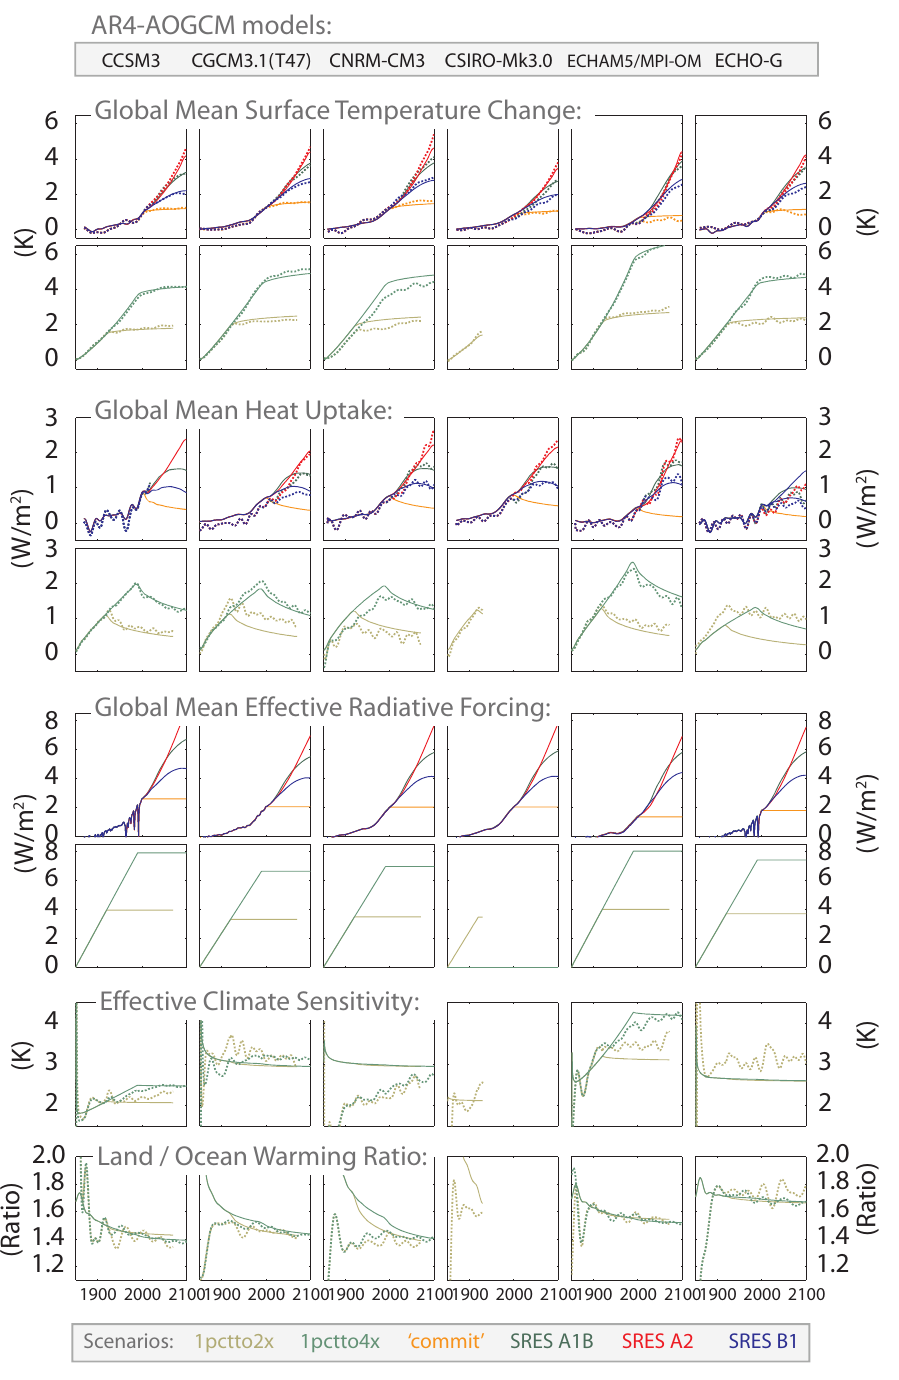
Fig. B1. Comparison of global-mean surface temperature (rows 1 and 2), heat uptake (rows 3, 4), effective radiative forcing (rows 5, 6), the effective climate sensitivity (row 7) and the land-ocean warming ratio (8), between CMIP3 AOGCM models (dotted) and the calibrated MAGICC6 (solid) model (calibration III with “like-with-like” AOGCM specific forcing) from 1850 to 2100. Shown are the comparisons for the idealized CO 2 -only scenarios (1pctto2 × and 1pctto4 × ) set to start in 1850 and the multi-forcing runs for the 20th century (20c3m), three SRES scenarios, and the commitment run. For the multi-gas scenarios, MAGICC is driven here by the AOGCM-specific subsets of forcing agents (see Table 2). AOGCM drift was removed by substracting the respective lowpass-filtered control run segments. Both the AOGCM and the MAGICC temperature outputs were lowpass-filtered using a low pass boundary of 0.05cycle/yr and roughness constraint (Mann, 2004). See following figures for the other CMIP3 AOGCMs